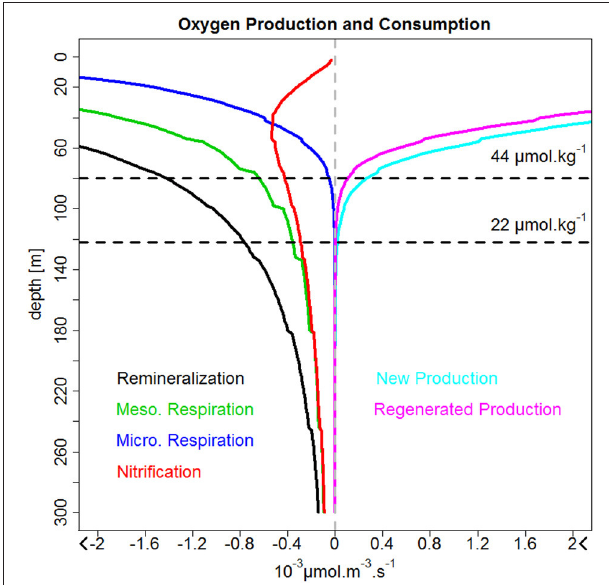
FIGURE 9 | Mean vertical profiles of the DO biogeochemical sources and sinks (in 10 − 3 µ mol O 2 m − 3 s − 1 ): new (cyan line) and regenerated (magenta line) production, remineralization (black line), respiration by microzooplankton (blue line) and microzooplankton (green line), and nitrification (red line). The profiles were computed from 6 ◦ S to 16 ◦ S and with 200km from the coast. Negative and positive values indicate DO consumption and production,